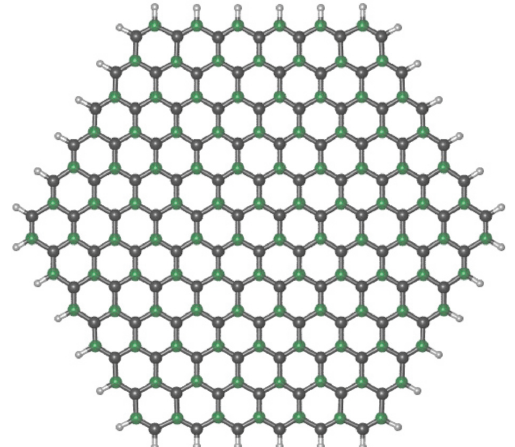
Figure 3: T 7 geometry: sublattice A in green; sublattice B in